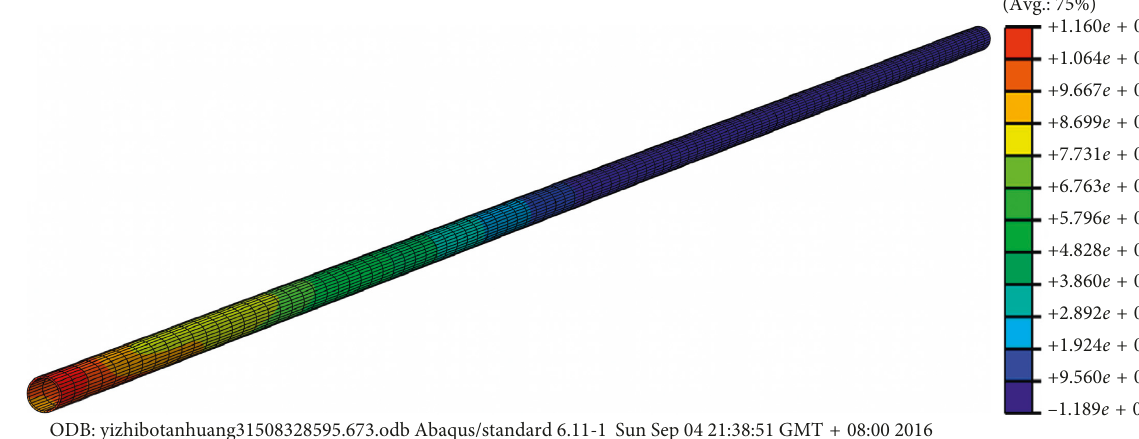
Figure 4: The maximum tensile stress nephogram at an incident angle of 0 ° under uniform seismic input motion.